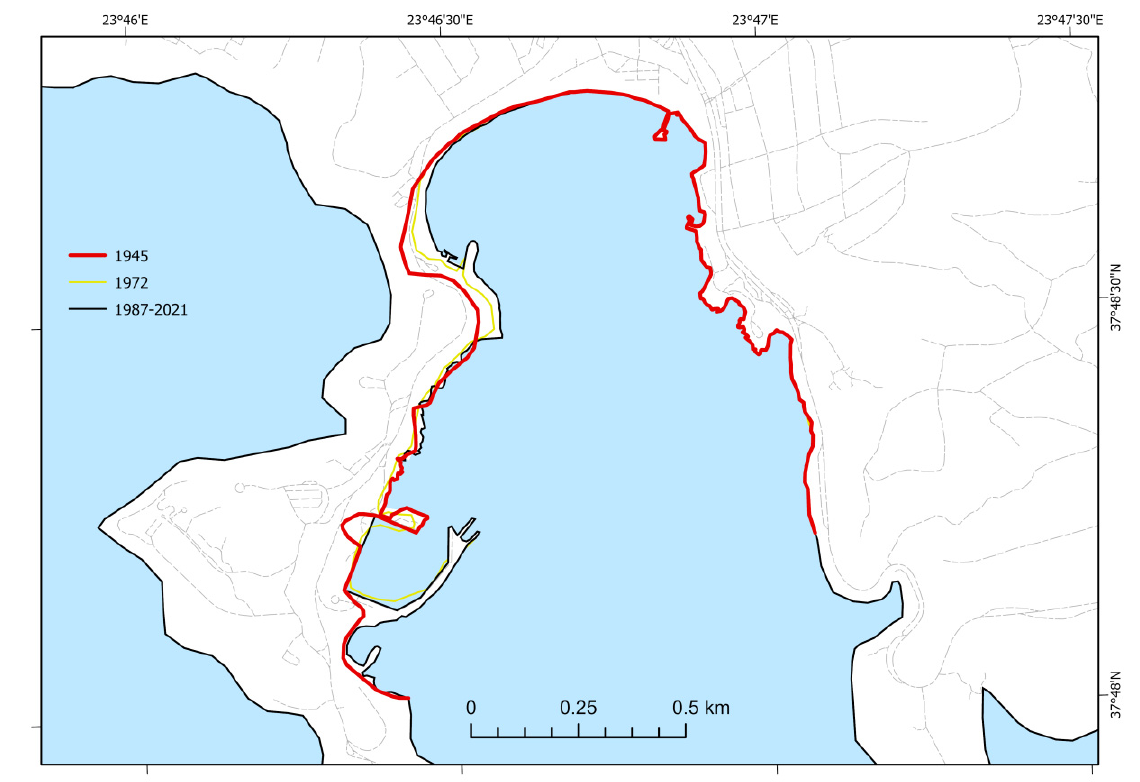
Figure 8. The coastlines and their temporal changes from 1945 to 2021 in Vouliagmeni Bay.